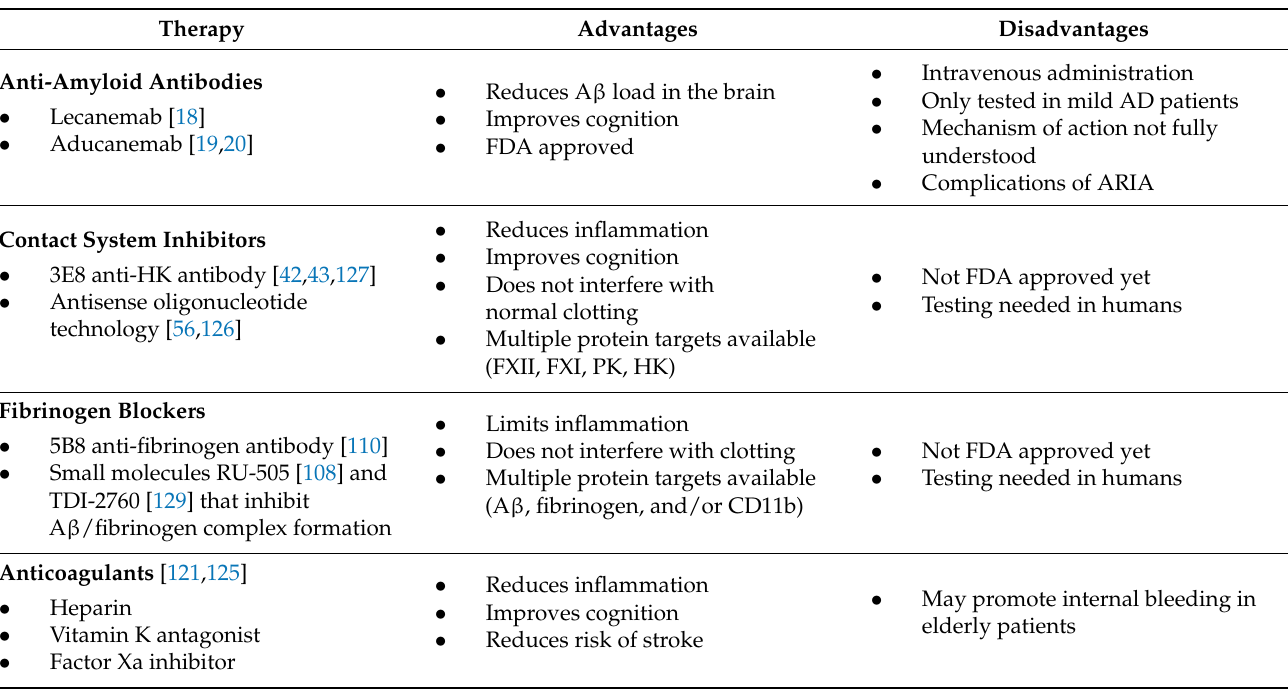
Table 1. Advantages and disadvantages of novel therapeutics for addressing vascular deficiencies in